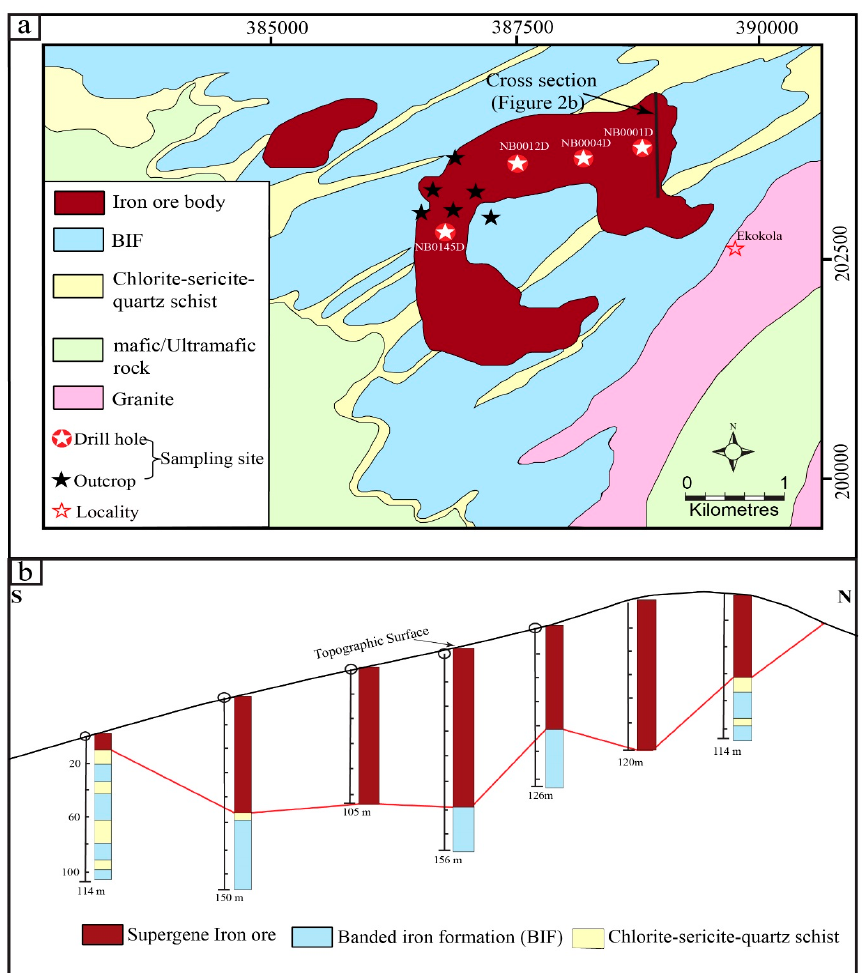
Figure 2. ( a ) Geology of the Nabeba deposit (modified after Longley et al. [8] and Meloux et al. [13]); ( b ) drill holes showing vertical zonation of the deposit. Abbreviations: NB0001D, Nabeba diamond drill hole 0001D; NB0004D, Nabeba diamond drill hole 0004D; NB0012D, Nabeba diamond drill hole 0012D; NB0145D, Nabeba diamond drill hole 0145D. Minerals 2019 , 9 , 677